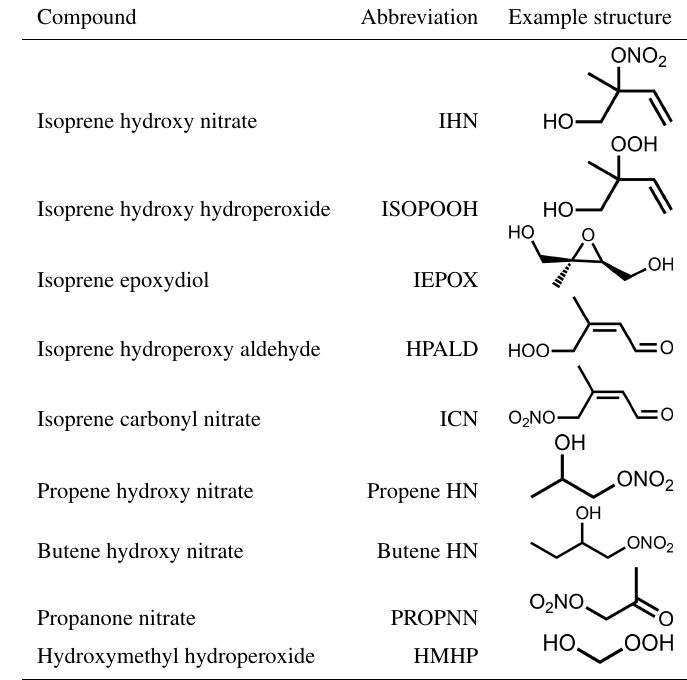
Table 1. Examples of OVOCs measured in this